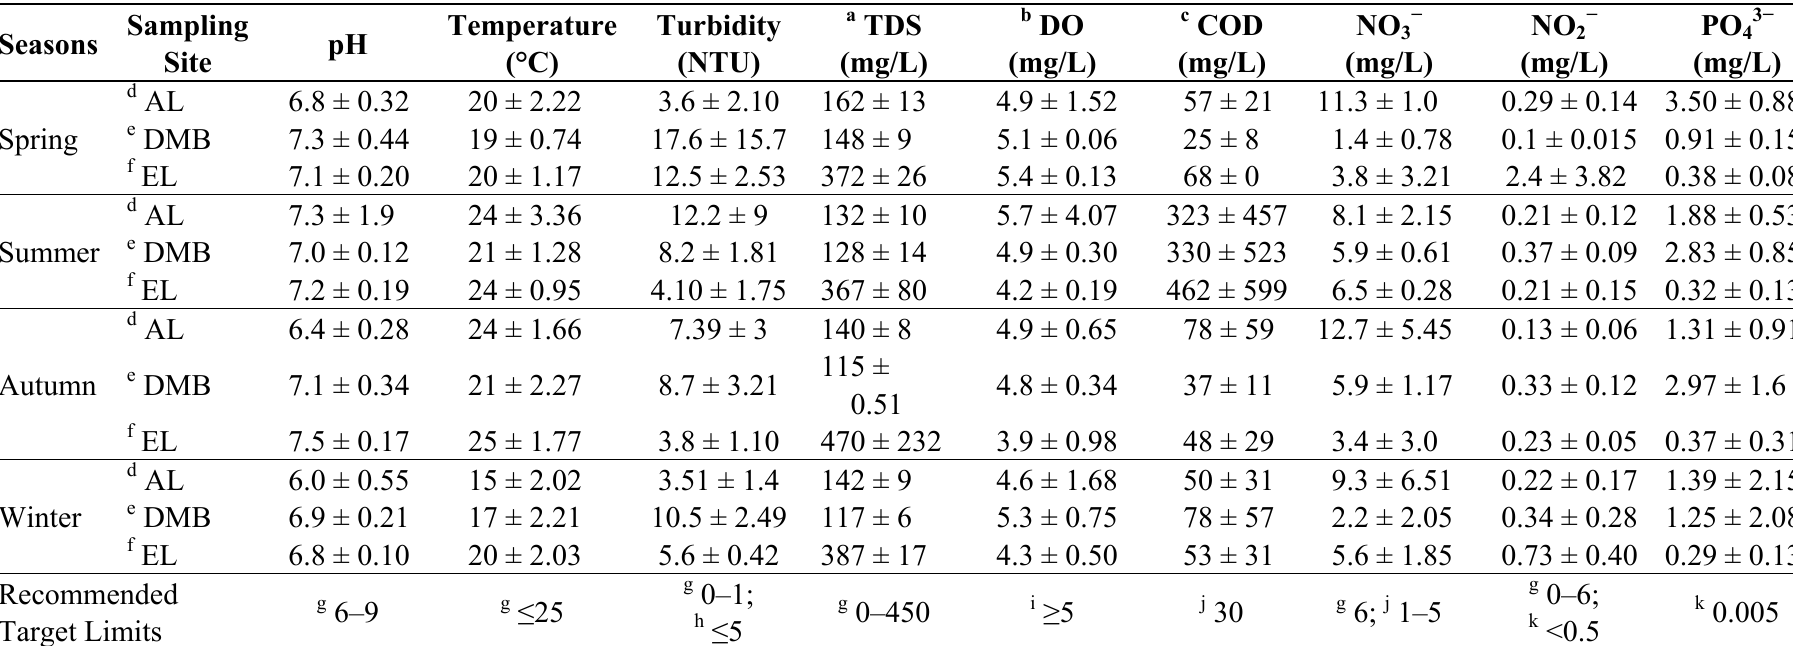
Table 1. Seasonal distribution of physicochemical parameters of treated wastewater effluents from the three studied plants.